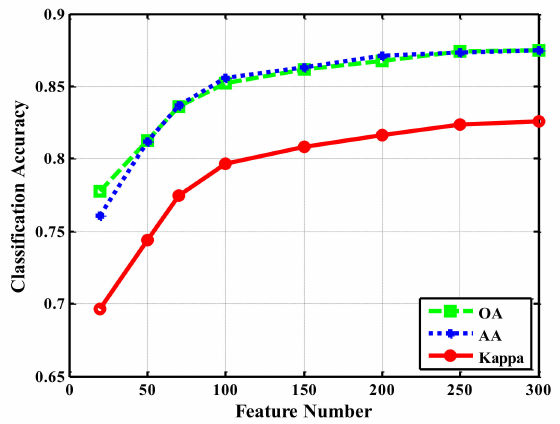
Figure 9. Classification accuracy of with different size of feature number.